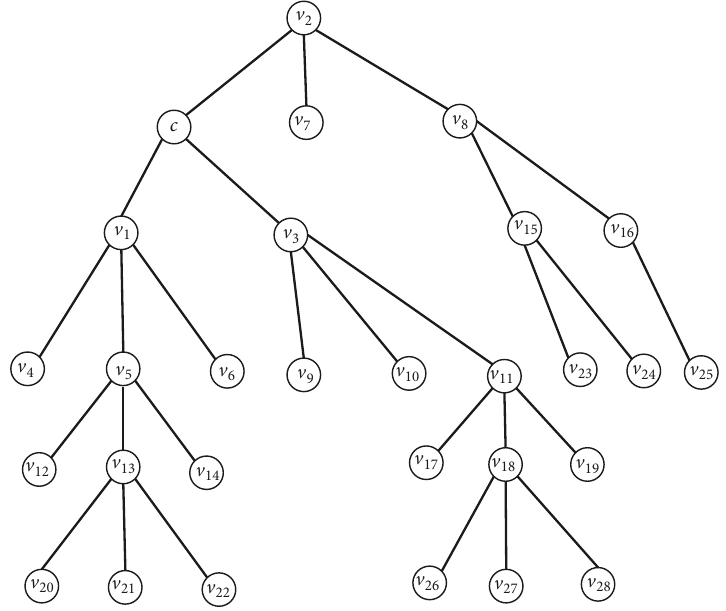
Figure 5: A rooted tree with root V 2 and 𝑐 is an internal